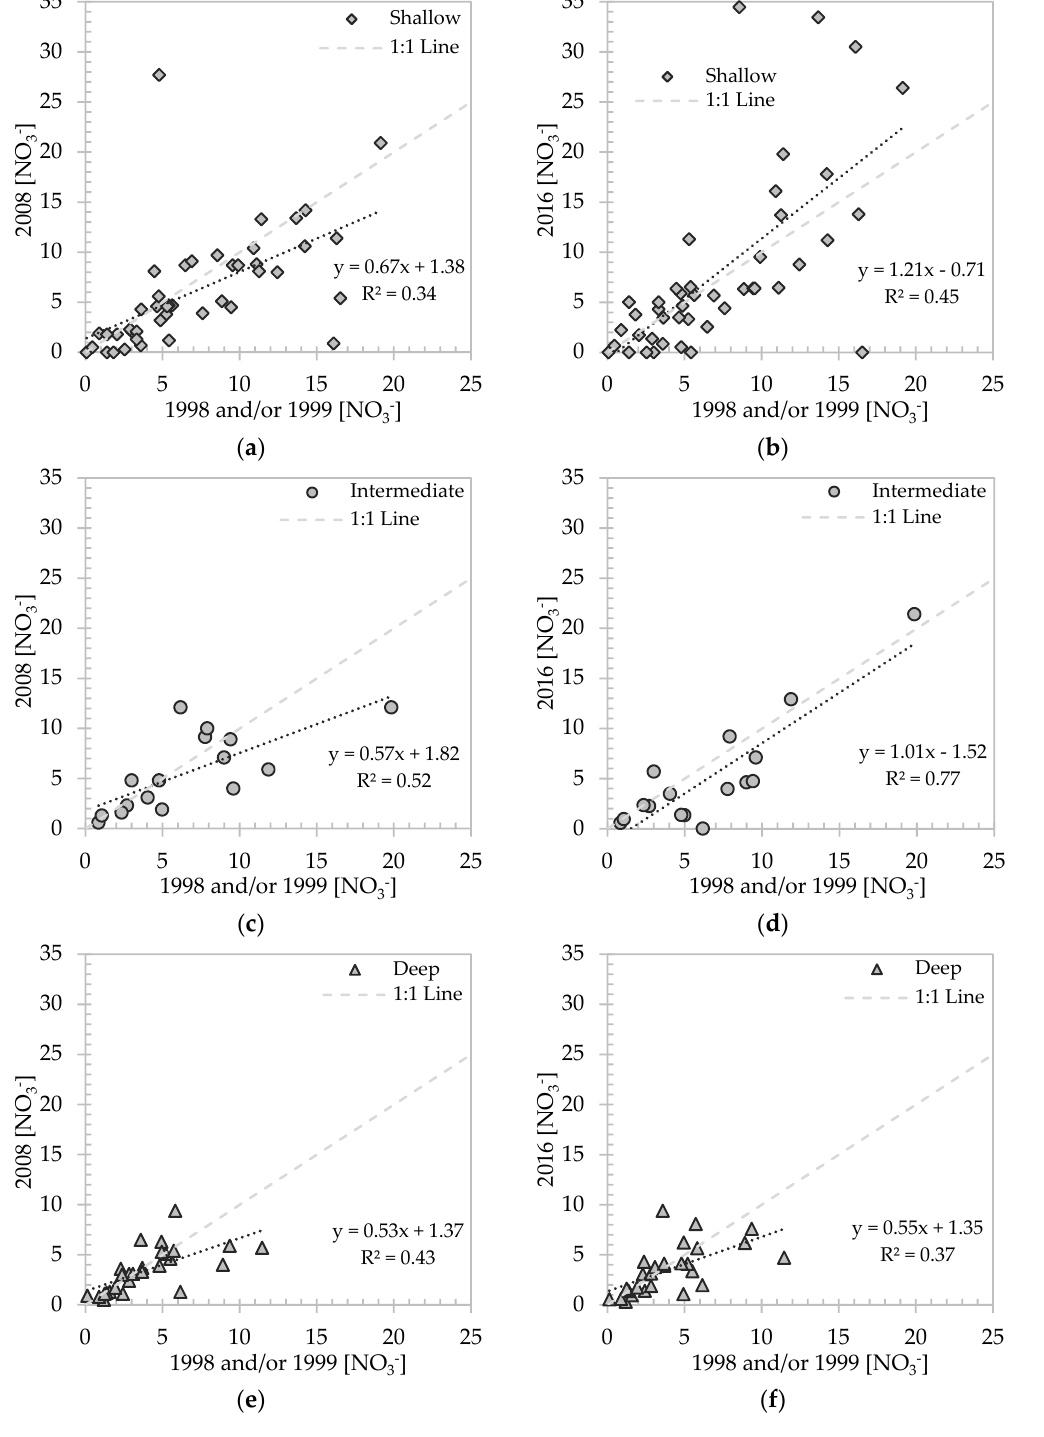
Figure 6. Comparison of groundwater [NO 3 − ] (mg N L − 1 ) from samples collected in 1998 and/or 1999 in shallow, intermediate, and deep wells to: ( a ) 2008 [NO 3 − ] in shallow wells ( n = 44); ( b ) 2016 [NO 3 − ] in shallow wells ( n = 44); ( c ) 2008 [NO 3 − ] in intermediate depth wells ( n = 16); ( d ) 2016 [NO 3 − ] in intermediate depth wells ( n = 16); ( e ) 2008 [NO 3 − ] in deep wells ( n = 27); and ( f ) 2016 [NO 3 − ] in deep wells ( n = 27).